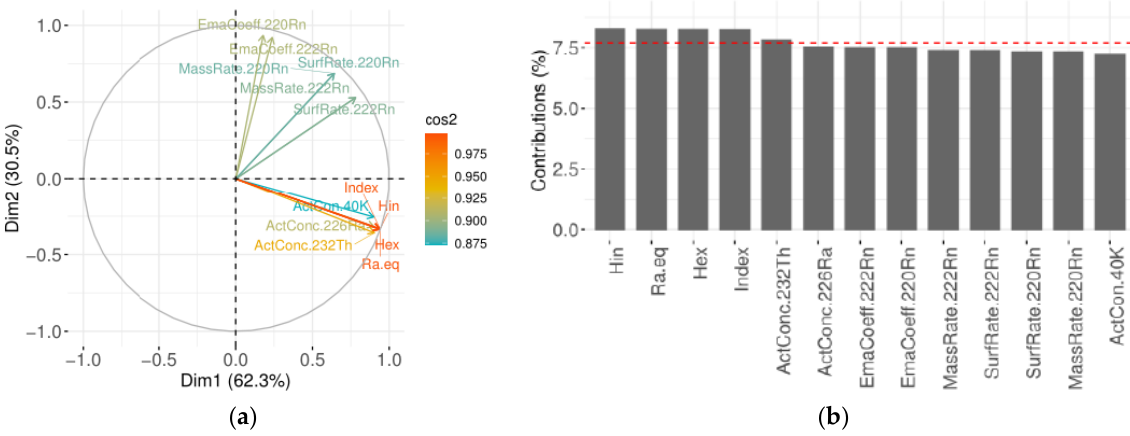
Figure 2. ( a ) The correlation circle obtained from the PCA; the palette of colors combined with the different values of cos 2 allows a faster interpretation of the results. ( b ) Percentage contribution of each variable to the determination of the first and second component.